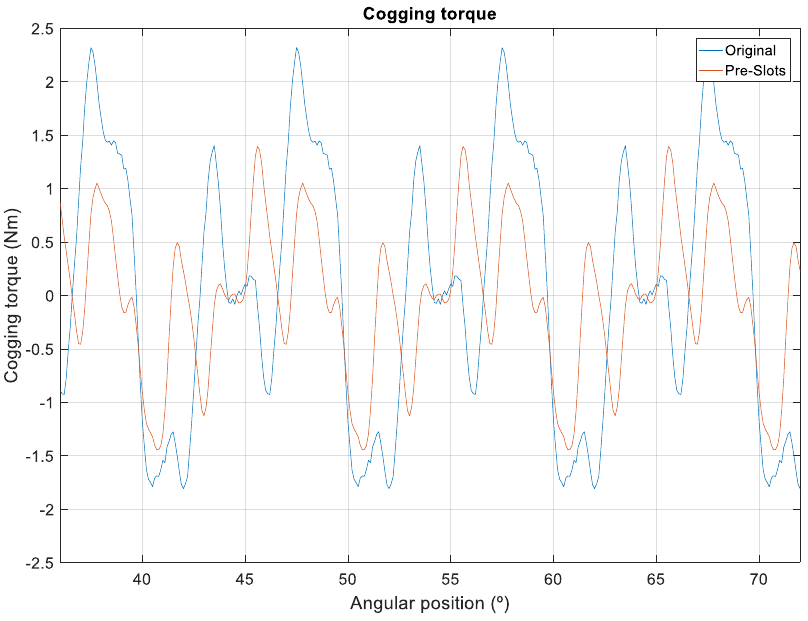
Figure 7. Comparison of cogging torque reduction with pre-slot method.